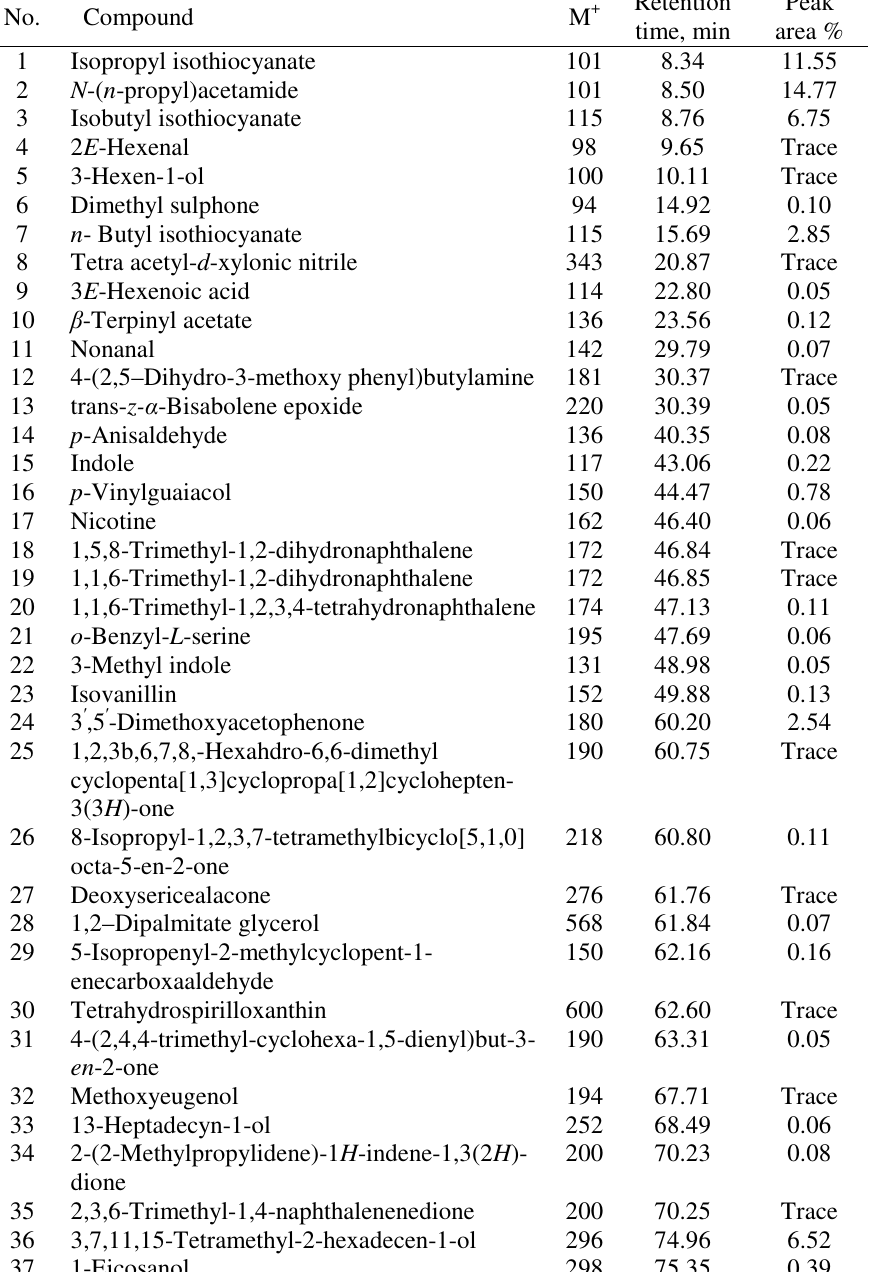
Table 1. Composition and percentage of the essential oil from Sisymbrium irio